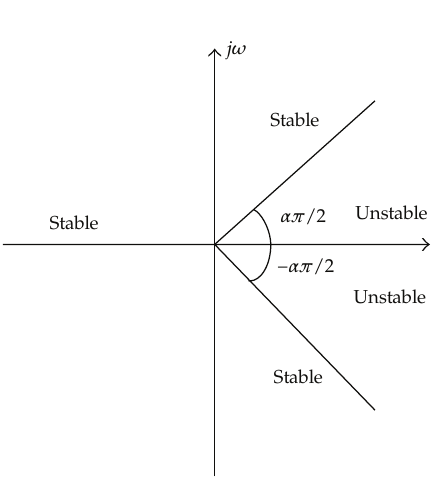
Figure 1: Stability region of the fractional-order